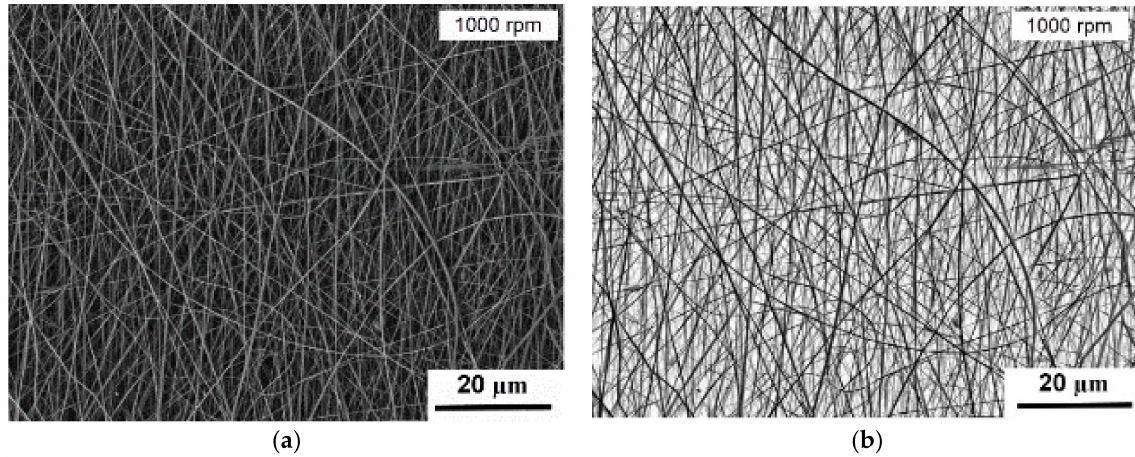
Figure 3. SEM image of polyvinyl chloride (PVC) nanofibers: ( a )—before processing; ( b )—after